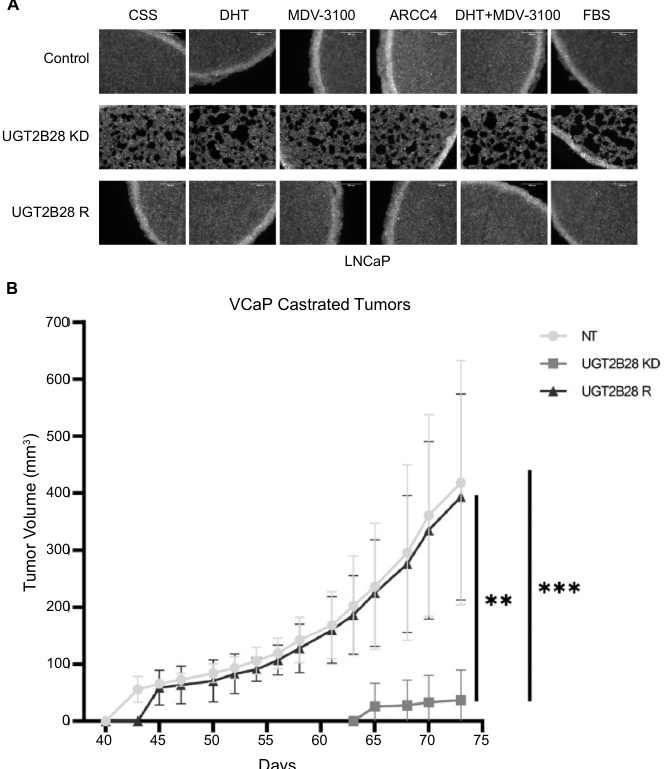
Figure 4. Prolonged tumor take and delayed tumor growth in response to UGT2B28 downregulation is independent of ligand dependent AR signaling. ( A ). 10 × GFP images of LNCaP organoids formed from non-targeting (NT), UGT2B28 KD, and UGT2B28 overexpression in KD4 background (UGT2B28 R) cells in response to treatment with charcoal-stripped serum (CSS), 1 nM 5 α -dihydrotestosterone (DHT), 10 µ M enzalutamide (MDV-3100), 300 nM ARCC4, 1 nM DHT + 10 µ M MDV-3100, and fetal bovine serum (FBS) for 24 h. n = 3. Scale bar = 500 µ m. ( B ). Tumor growth curve for NT, UGT2B28 KD, and UGT2B28 R VCaP xenografts in castrated, athymic nude mice. The data are represented as the mean + / − the standard deviation (SD). ** p < 0.001, *** p < 0.0001. NT, n = 6, UGT2B28 KD, n = 7, UGT2B28 R, n =